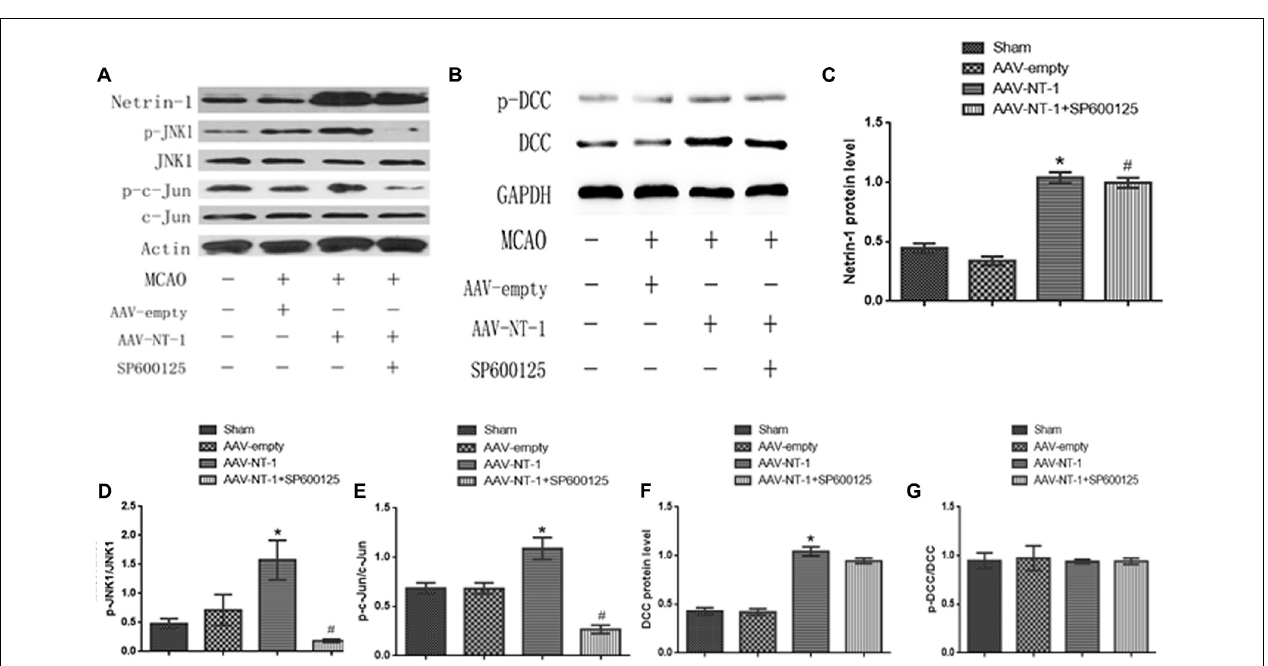
group (respectively, 1.0400 ± 0.04726 vs. 0.3400 ± 0.03512, p < 0.001; 0.9967 ± 0.04096 vs. 0.3400 ± 0.03512, p < 0.001) ( Figure 3C